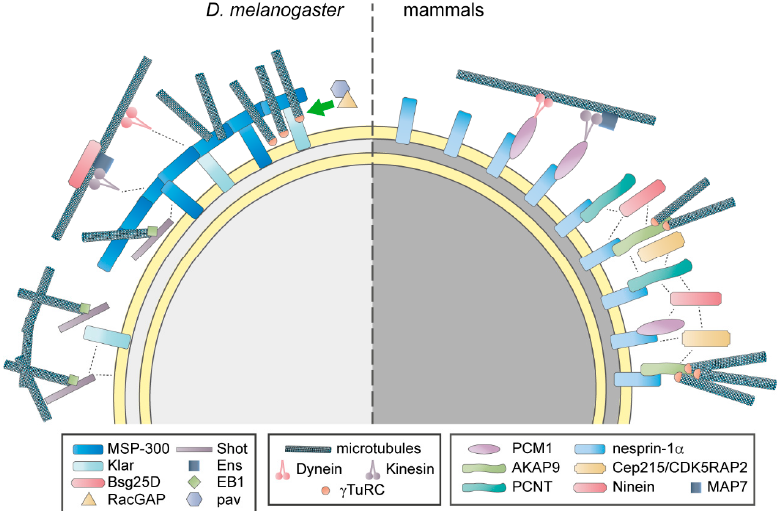
Figure 2. The nuclear envelope microtubule-organizing center (MTOC) in Drosophila ( D.) melanogaster and in mammalian muscle cells. In D. melanogaster , the outer nuclear membrane proteins MSP-300 and Klarsicht (Klar), as well as a complex of the spectraplakin Shortstop (Shot) and the microtubule plus-end tracker EB1, cooperate to maintain a circumnuclear MSP-300 ring. Potentially, this ring is constituted by isoforms of MSP-300 that lack the nuclear envelope-targeting Klarsicht, ANC-1, and Syne homology (KASH) domain. The perinuclear microtubule network is maintained by the MSP-300 ring and the Shot-EB1 complex. Additionally, RacGAP and its binding partner Pavarotti (pav) promote perinuclear γ TuRC localization. Dynein and a complex of kinesin, ensconsin (Ens), and Bsg25D mediate nuclear movement along microtubules. Klar and MSP-300 have been proposed as direct interaction partners of dynein and kinesin. In mammals, nesprin-1 α anchors the centrosomal proteins pericentriolar material 1 (PCM1), pericentrin (PCNT), and A-kinase anchoring protein 9 (AKAP9) to the nuclear envelope. PCM1 connects the nucleus to microtubule-associated motors. AKAP9 is specifically required for microtubule nucleation, potentially by recruiting γ -tubulin ring complexes ( γ TuRC). Ninein and centrosomal protein of 215 kDa (CEP215/CDK5RAP2) localize to the nuclear envelope, but the underlying mechanisms are unclear. Ortho- and paralogues have the same shape and similar color. Dashed lines represent hypothetical interactions that underlie nuclear envelope localization of MTOC components. Please note that a large part of the D. melanogaster data has been obtained in myofibers in vivo, while mammalian data derives largely from in vitro experiments in myotubes. This possibly accounts for some of the differences in ncMTOC composition. Anchoring of MTOC proteins depends on a muscle-specific isoform of the outer nuclear membrane protein nesprin-1, nesprin-1 α [60,178], which belongs to the Klarsicht, ANC-1, and Syne homology (KASH) protein family [179,180]. KASH proteins form, together with Sad1 and UNC-84 (SUN) proteins at the inner nuclear membrane, the linker of nucleoskeleton and cytoskeleton (LINC) complex [181–183]. Depletion of nesprin-1 α dispersed PCM1, PCNT, and AKAP9 from the nuclear envelope and premature expression of nesprin-1 α in undifferentiated (i.e. myogenin-negative) myoblasts was sufficient to recruit a fraction of endogenous PCM1 as well as an ectopically expressed centrosome-targeting domain of PCNT and AKAP9 (i.e. PACT domain) [60]. Yet, it remains unclear whether nesprin-1 α is sufficient (1) to recruit endogenous PCM proteins in myoblasts, or (2) to induce nuclear envelope recruitment of MTOC components in non-muscle cells. Apart from the anchor nesprin-1 α not much is known about the mechanisms underlying the transition from centrosomal to non-centrosomal MTOC. Interestingly, nuclei of non-muscle cells